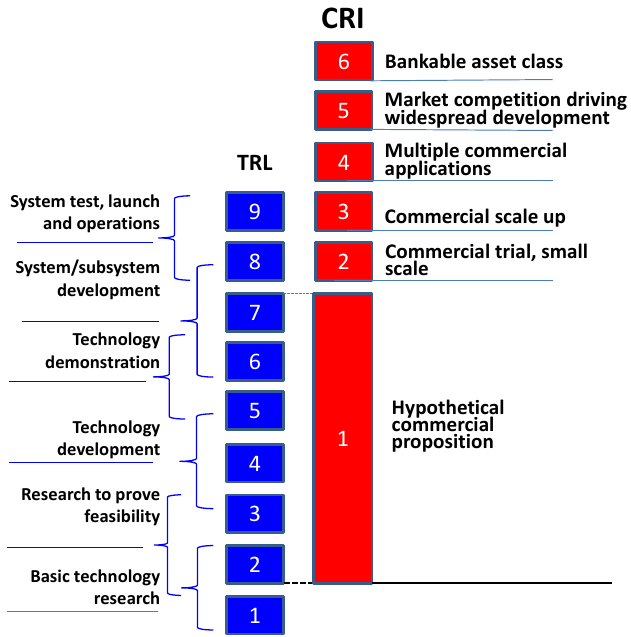
of hydrogen in various modes of transport.